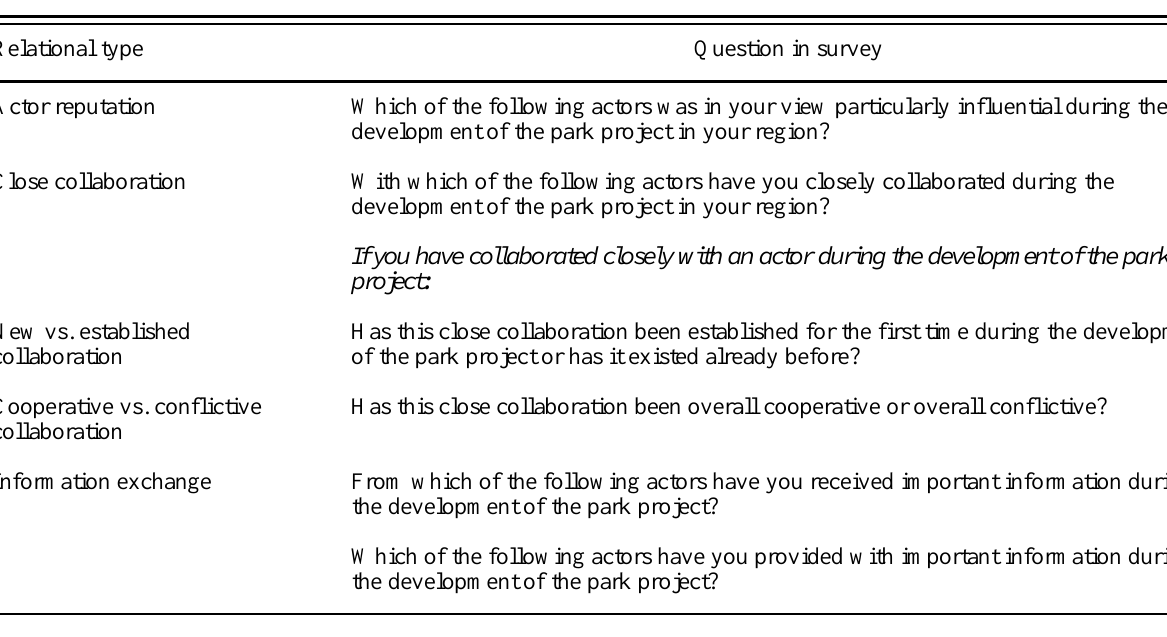
Table 1. Relational types and